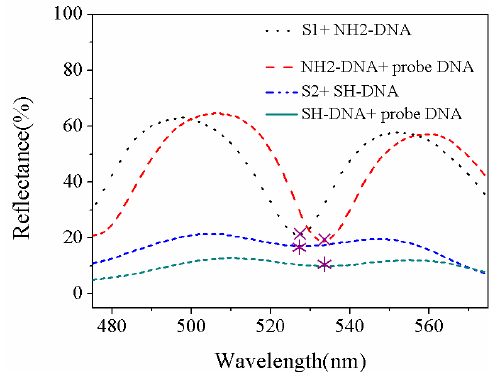
Figure 9. The movement of the reflection spectra from the probe DNA binds to the sensor substrates. The first type sensor substrate (S1) functional with glutaraldehyde, is easy to connect with amino-modified DNA fragments; the second type sensor substrate (S2) is readily connected sulfhydryl -modified DNA by adsorbed Au NPs.